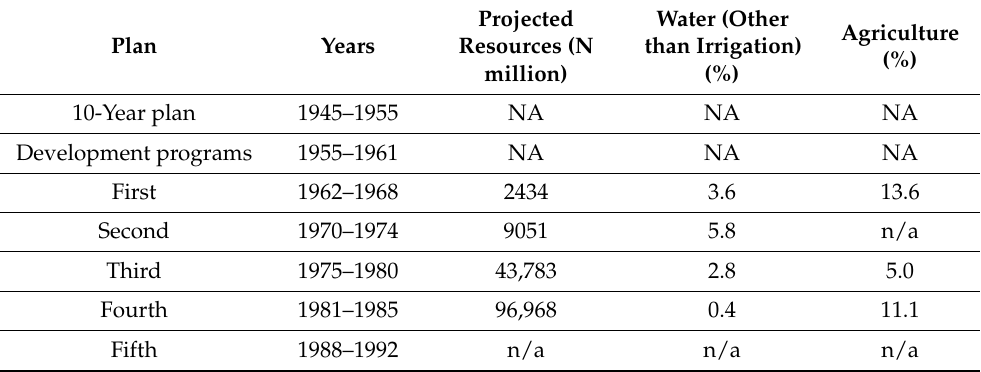
Table A3. Federal government capital expenditure for water and agriculture in the national develop- ment plans. Source: Authors.